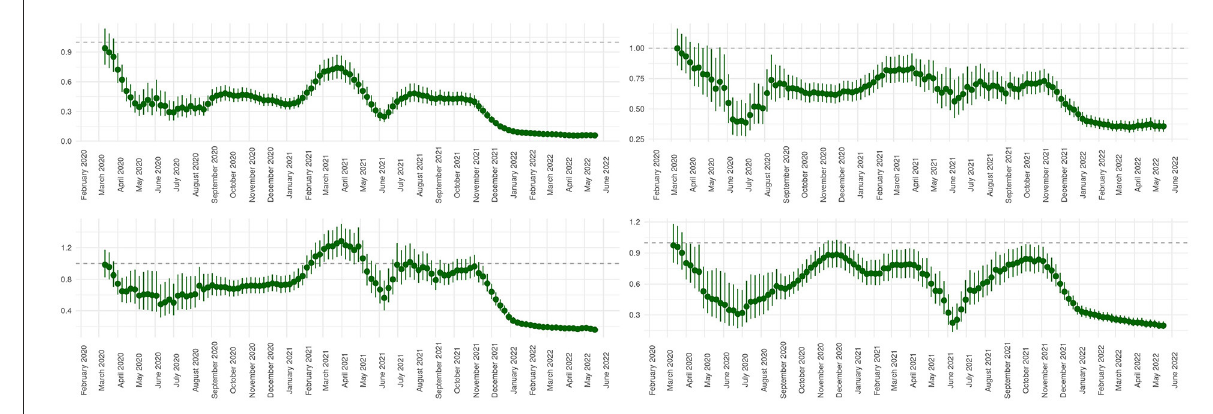
FIGURE3 Sliding comparison of 9-week periods with the first pandemic wave investigating occurrence of SARI, intensive care therapy, mechanical ventilation, and in-hospital mortality. The presentation of 9-week periods (sliding ORs) that are temporarily assigned to the beginning of the interval lead to a time shift of the corresponding trends when being compared to Figure 2. For the same reason the graphs end before the end of the study period. All shown analyzes are adjusted for age, gender, and Elixhauser comorbidity index. (Upper left panel) Sliding comparison of the proportion of encoded SARI. (Upper right panel) Sliding comparison of the proportion of patients receiving intensive care therapy. (Lower left panel) Sliding comparison of the proportion of patients receiving mechanical ventilation. (Lower right panel) Sliding comparison of in-hospital mortality